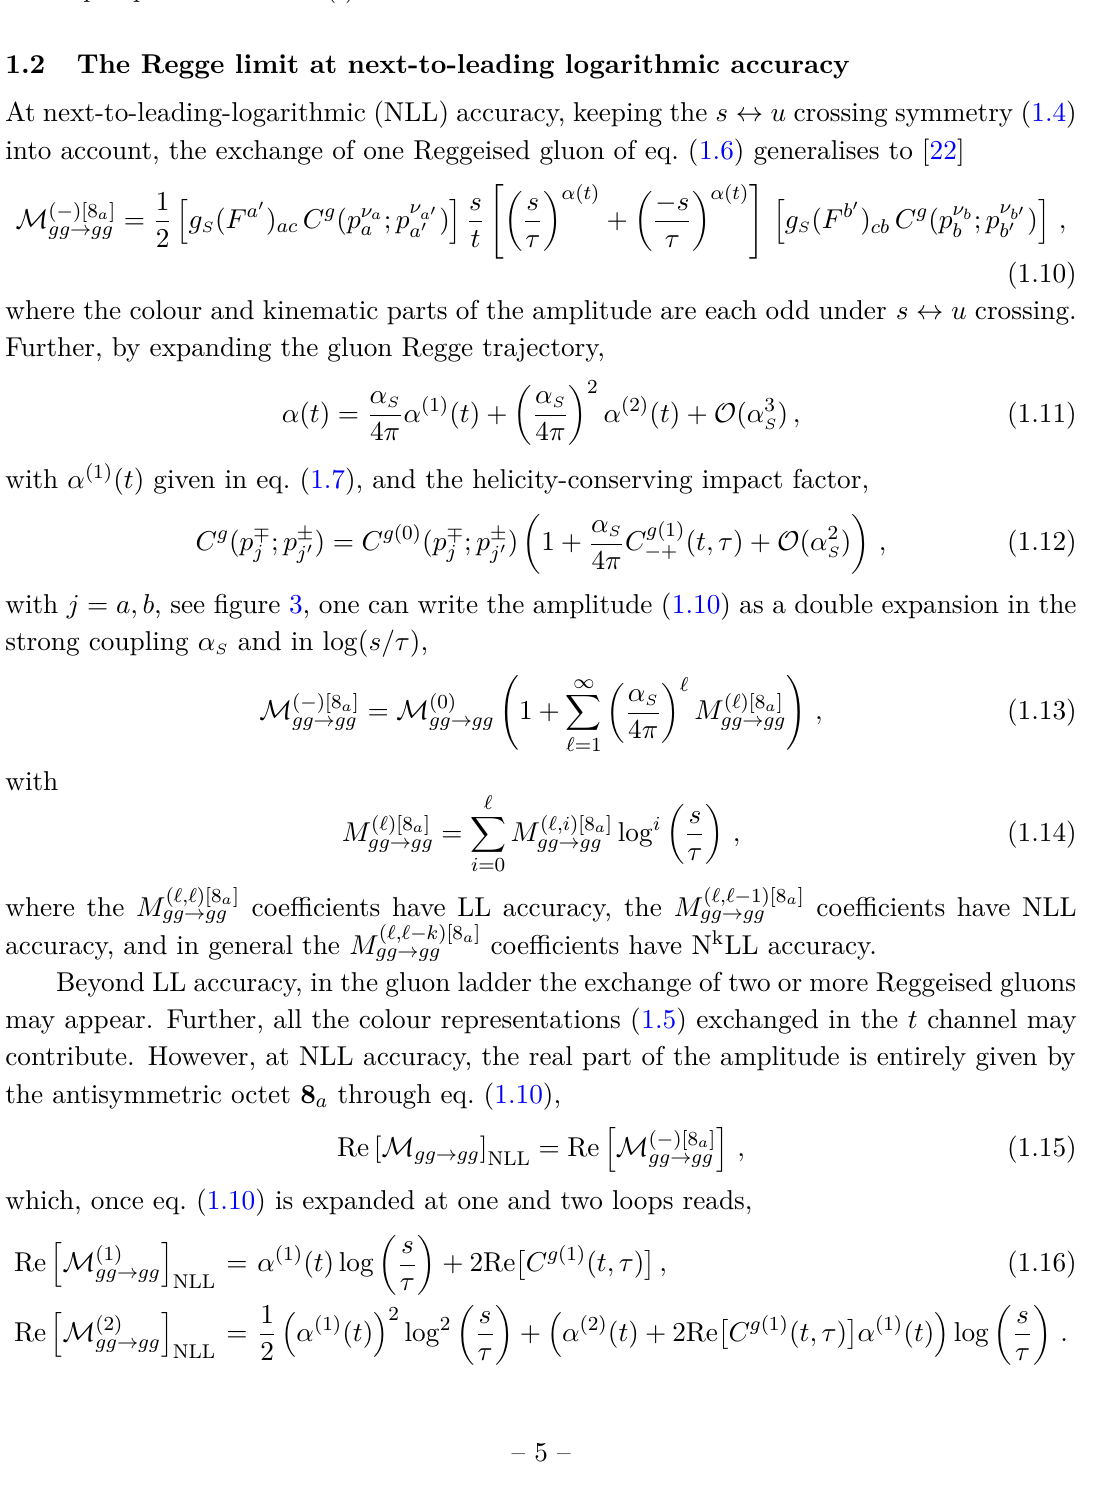
Figure 3 . Impact factors in the one-loop four-gluon amplitude. The pierced blobs represent the one-loop impact factors C g (1) ( t )